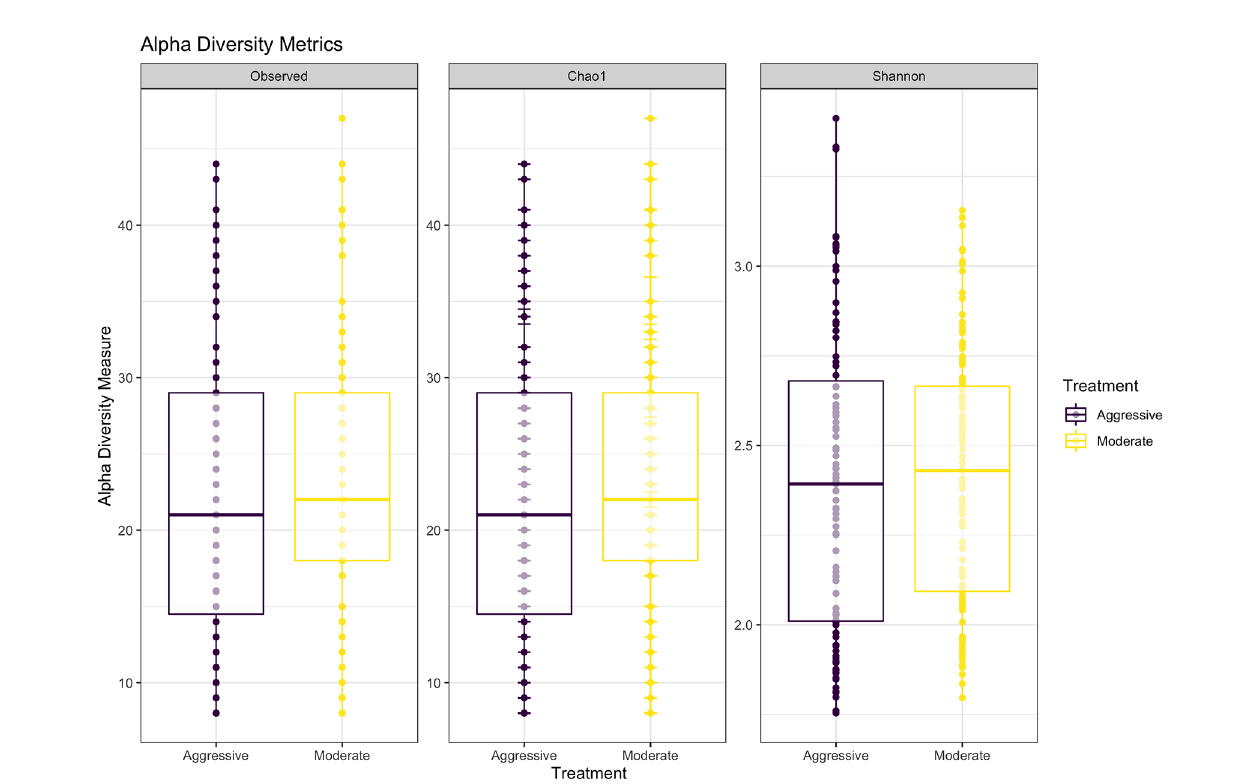
FIGURE 8 | Alpha-diversity metrics for protozoal communities with observed abundances of communities, expected abundances (Chao1), and richness and diversity measured with Shannon diversity index. There were no signi fi cant differences between alpha-diversity metrics between moderate and aggressive implant strategies. Aggressive treatments are represented in purple and moderate treatments are represented in